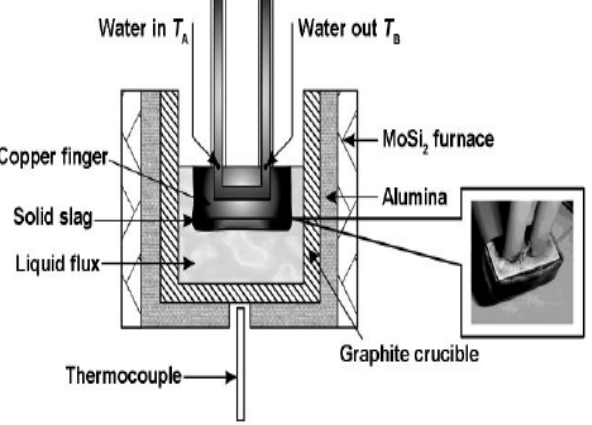
Figure 3. The probe diagram of the mold heat flow simulator.